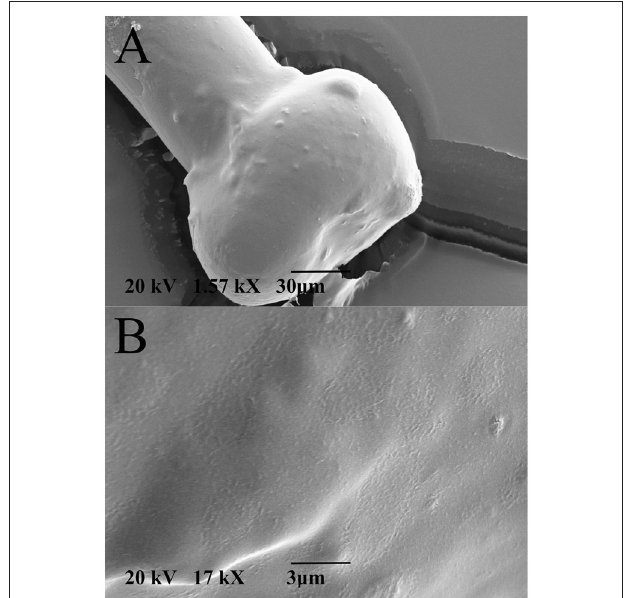
FIGURE 3 | Representative SEM micrographs of (A) pHEMA-encapsulated PEDOT-PSS-CNT microsphere and (B) higher magnification of the pHEMA coating.